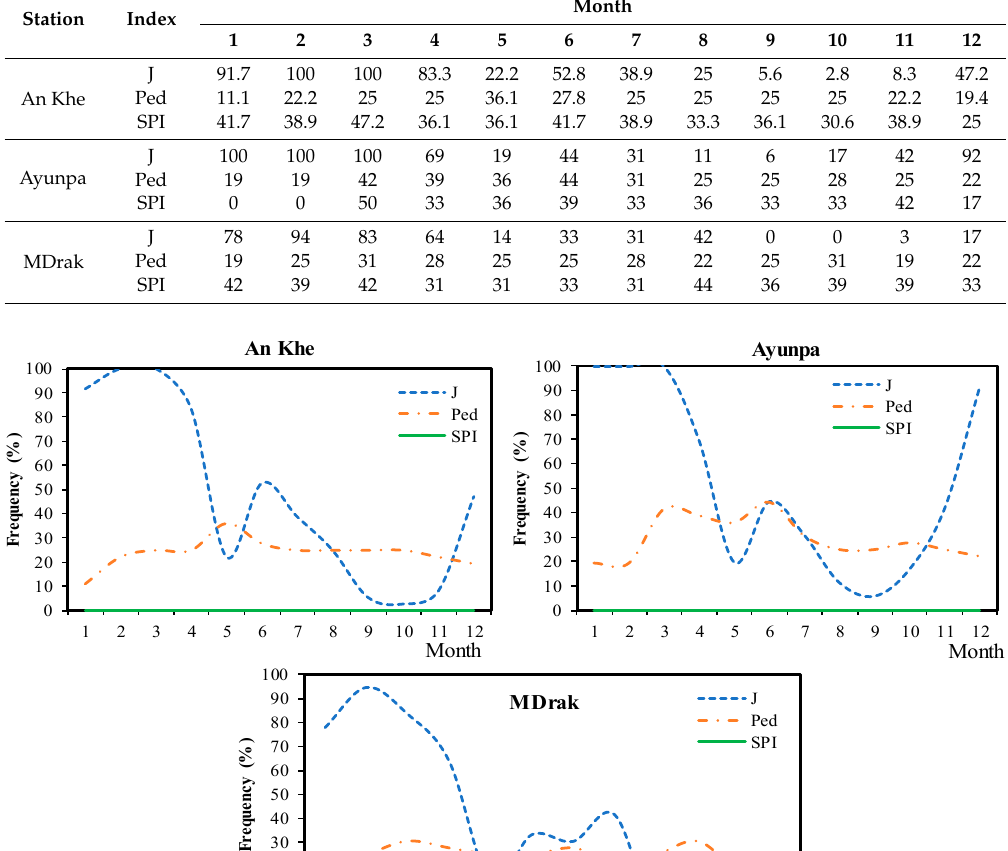
Table 4. The frequency of monthly drought, based on the three indices, at the An Khe, Ayunpa, and MDrak stations.